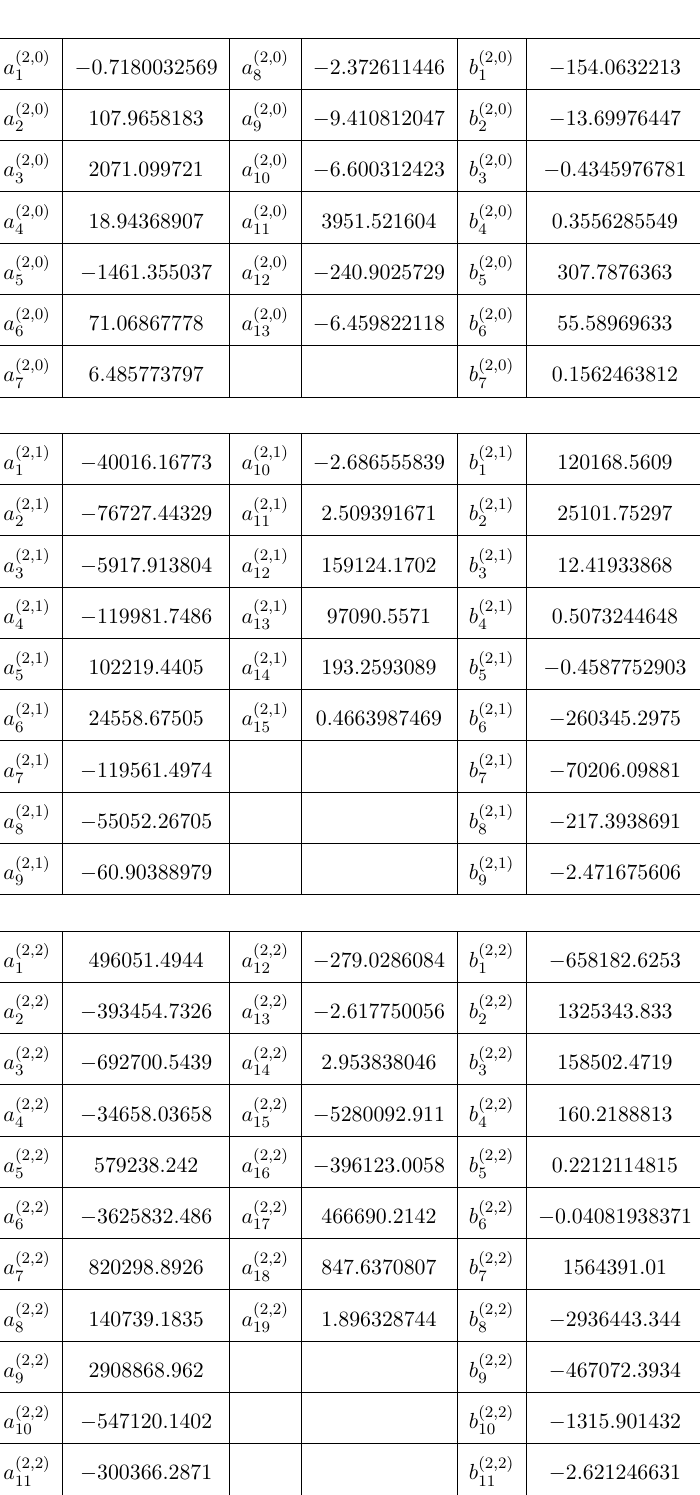
Table 2 . Coe(cid:14)cients of the (cid:12)t functions F (2 ;j ) for j = 0 ; 1 ; 2.